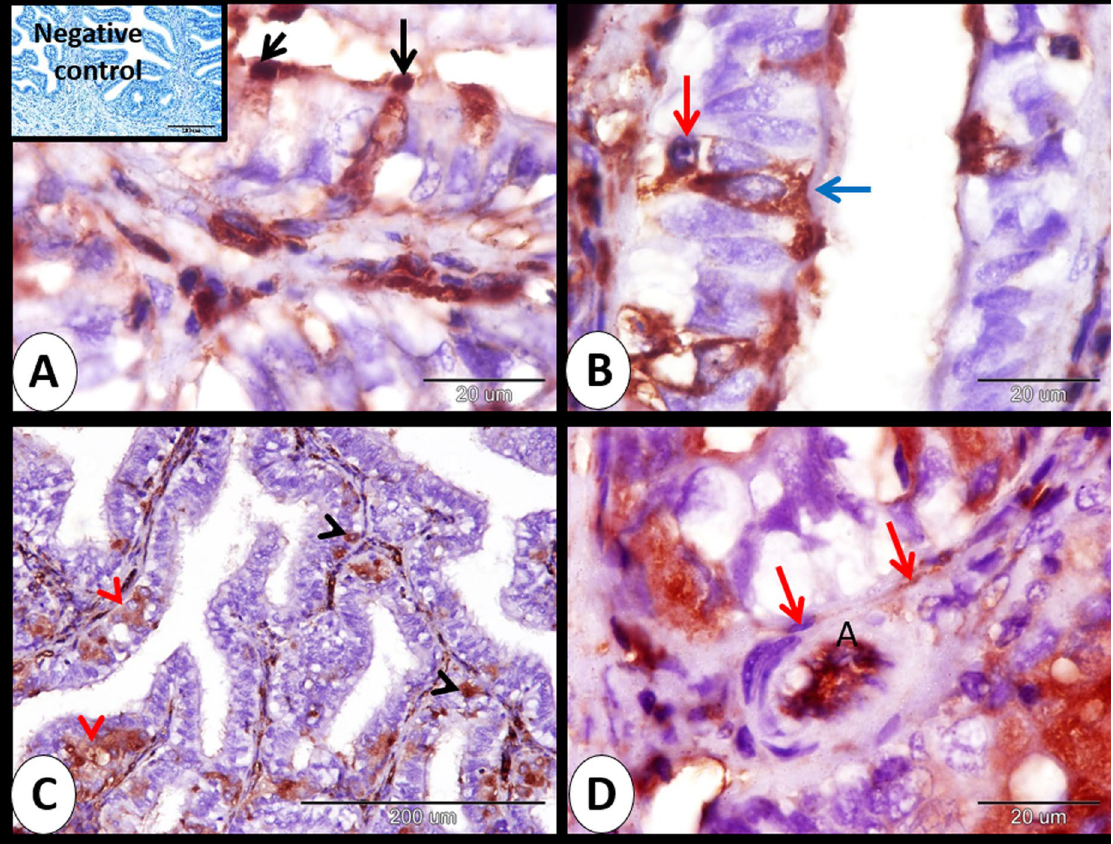
( B ) ciliated cell (blue arrow) showed moderate cytoplasmic and negative nuclear immunostaining and intraepithelial lymphocytes (red arrow) showed moderate cytoplasmic ERA immunostaining. ( C ) intraepithelial neuroendocrine cells distributed singly (black arrowheads) or in groups (red arrowheads) expressed mild to strong cytoplasmic and nuclear immunostaining to ERA. ( D ) subepithelial telocytes (red arrows) showed moderate cytoplasmic and mild nuclear immunostaining to ERA and the artery endothelium ( A ) showed strong immunoreactivity to ERA. Note, bordered area in A the negative